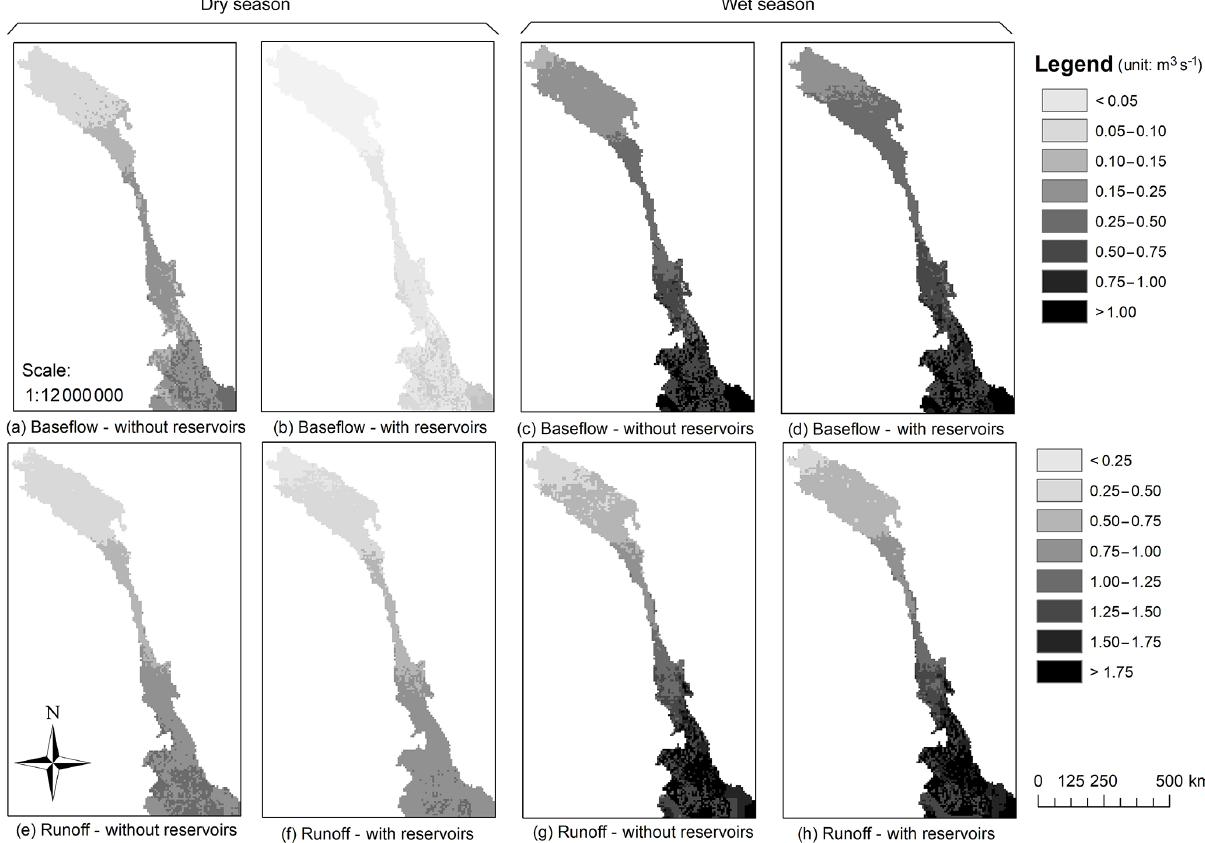
Figure 8. Average values of simulated baseflow (a, b, c, d) and runoff (e, f, g, h) simulated by the selected models (with and